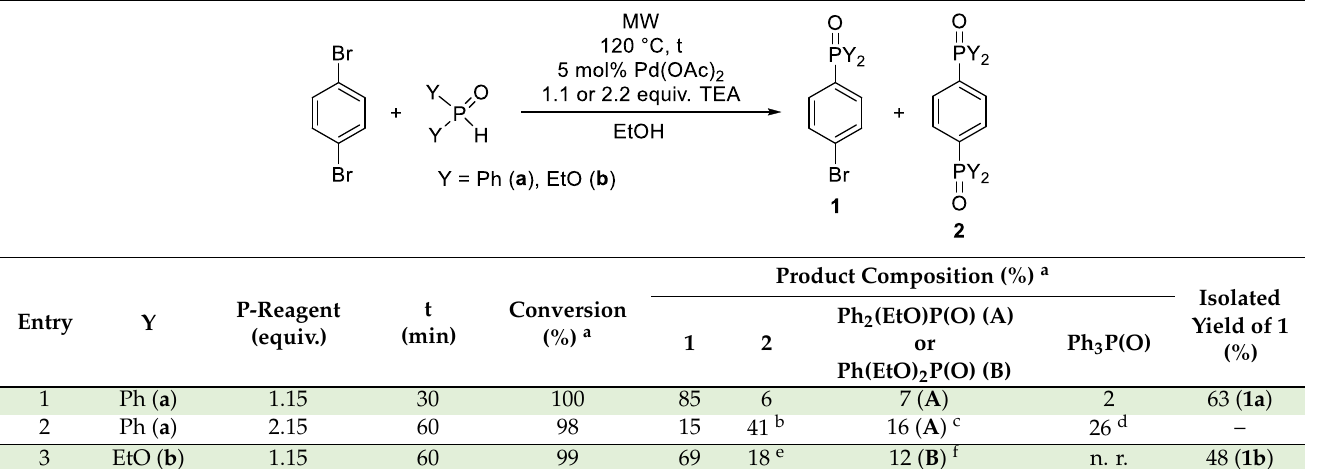
Table 2. P–C coupling reactions of 1,4-dibromobenzene. Table 2. P – C coupling reactions of 1,4-dibromobenzene.